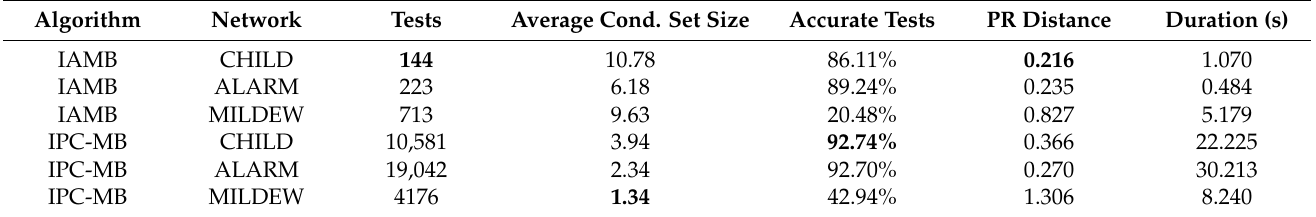
Table 2. G-test results across all datasets of 800 samples for IAMB and IPC-MB.